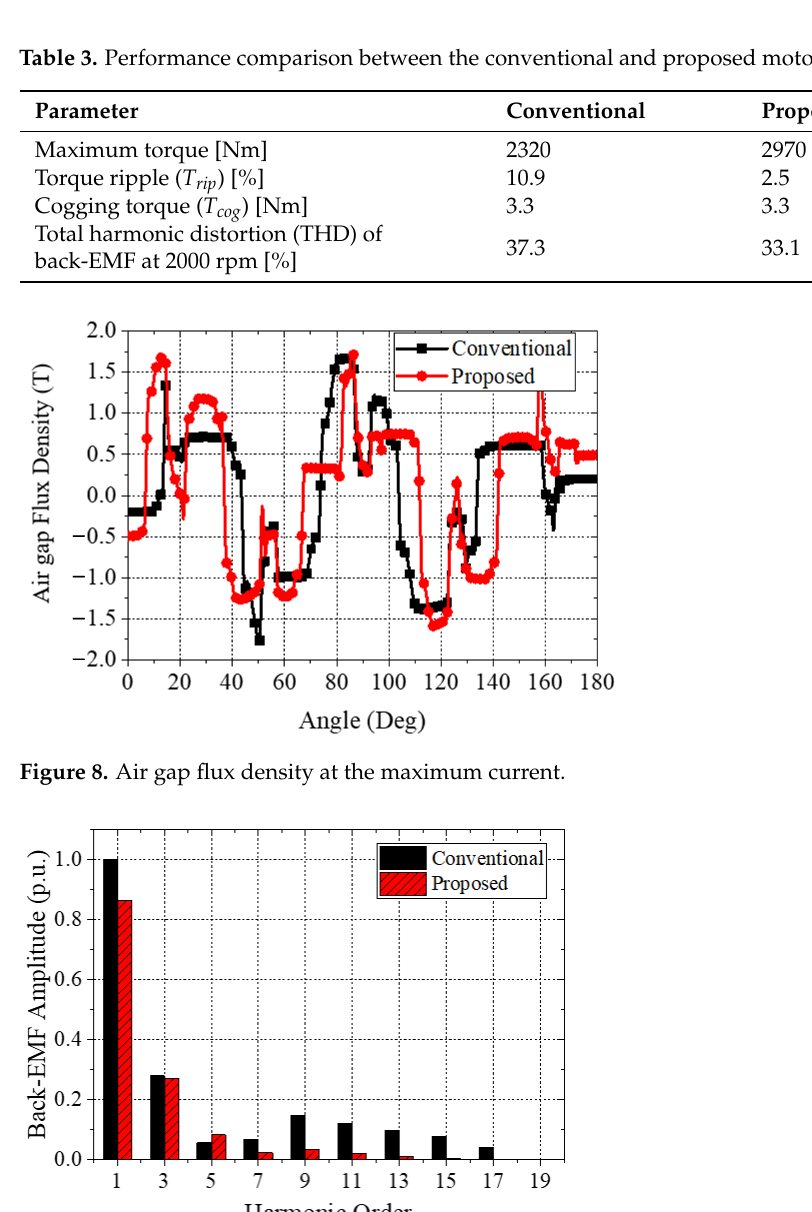
( b ) Figure 10. Design of 6Φ -SS-FSCW-Fer-SIPMSM ( a ) without and ( b ) with circular notch on the rotor and rectangular nonmagnetic shaft fixture.